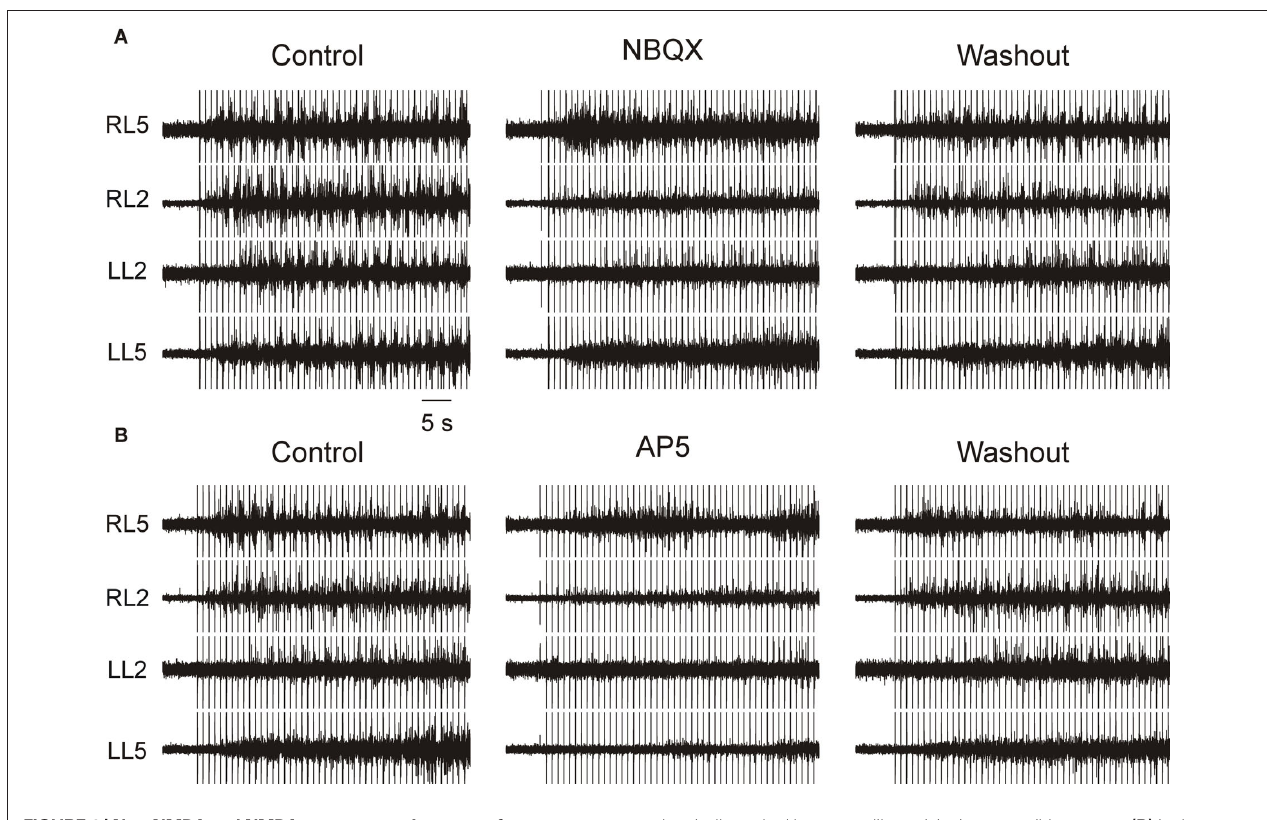
Figure 1 | Non-NMDA and NMDA receptors are important for neural-evoked locomotor-like activity. Stimulation frequency is 1 Hz. All ventral root recordings are in AC mode. (A) Application of 10 μM NBQX completely prevented or severely impaired the